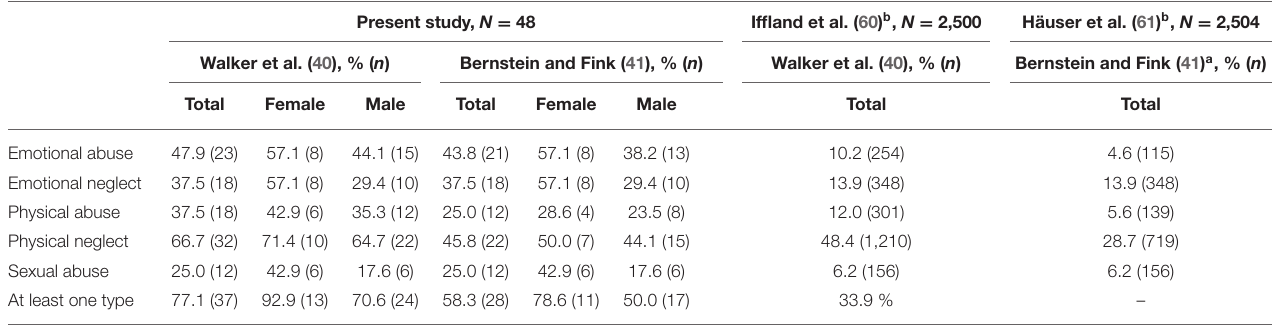
TABLE 2 | Prevalence rates of childhood maltreatment based on thresholds as established by Bernstein and Fink (41) and Walker et al. (40) in the present study with SSD patients and in a representative sample of the German population. Present study, N = 48 Iffland et al. (60) b , N = 2,500 Häuser et al. (61) b , N = 2,504 Walker et al. (40), % ( n ) Bernstein and Fink (41), % ( n ) Walker et al. (40), % ( n